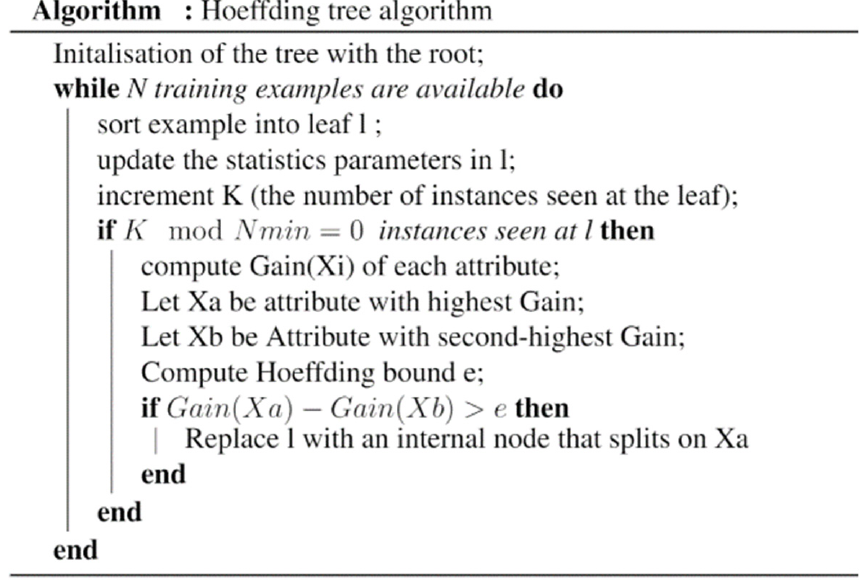
Figure 4. The pseudo code of the Hoeffding tree algorithm [43] .